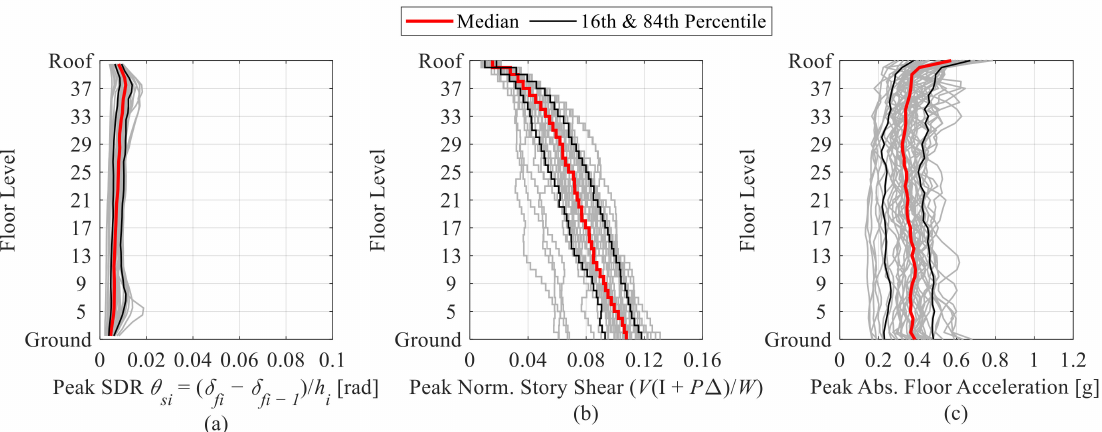
Figure 12. Engineering demand parameters of the retrofitted building (BSE-1E), ( a ) peak SDR, ( b ) peak normalized story shear force, ( c ) peak absolute floor